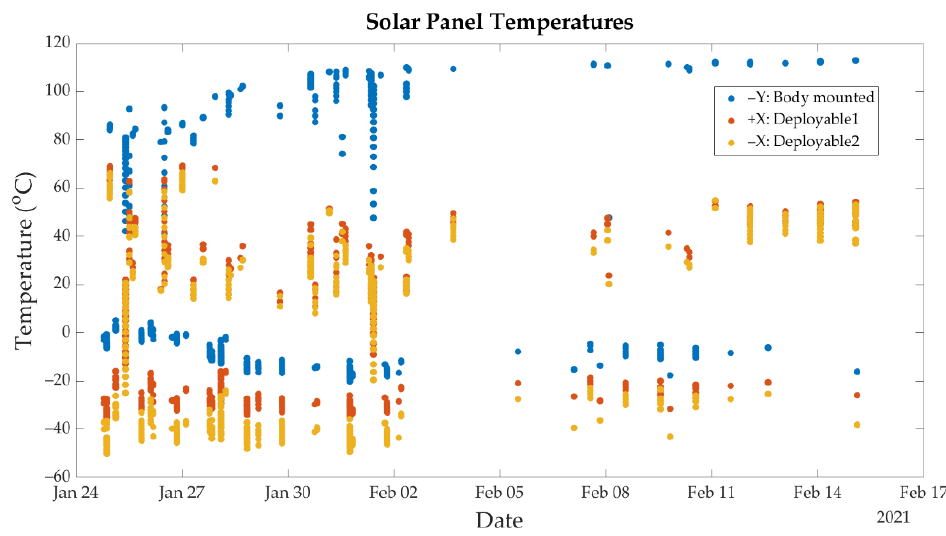
Figure 22. Solar panel temperatures measured on-orbit as a function of time.